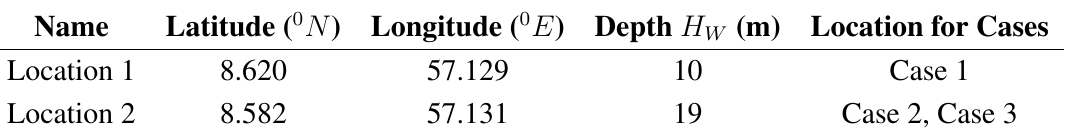
Table 5. Location dependent values from [21] for the different Wavestar